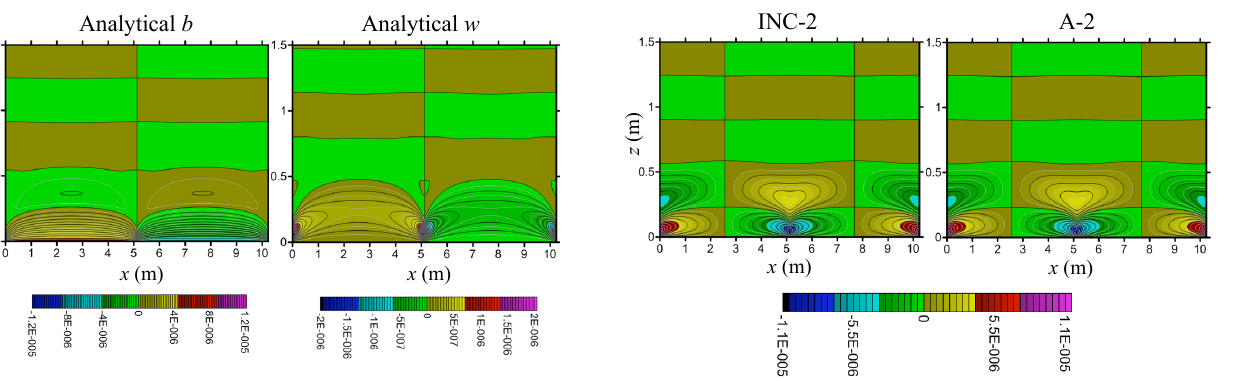
Figure 5. Vertical cross section of u from the second test case. A-2 is the analytical solution. INC-2 is the numerical simulation with inhomogeneous Neumann condition for pressure. Colour bar units are ms − 1